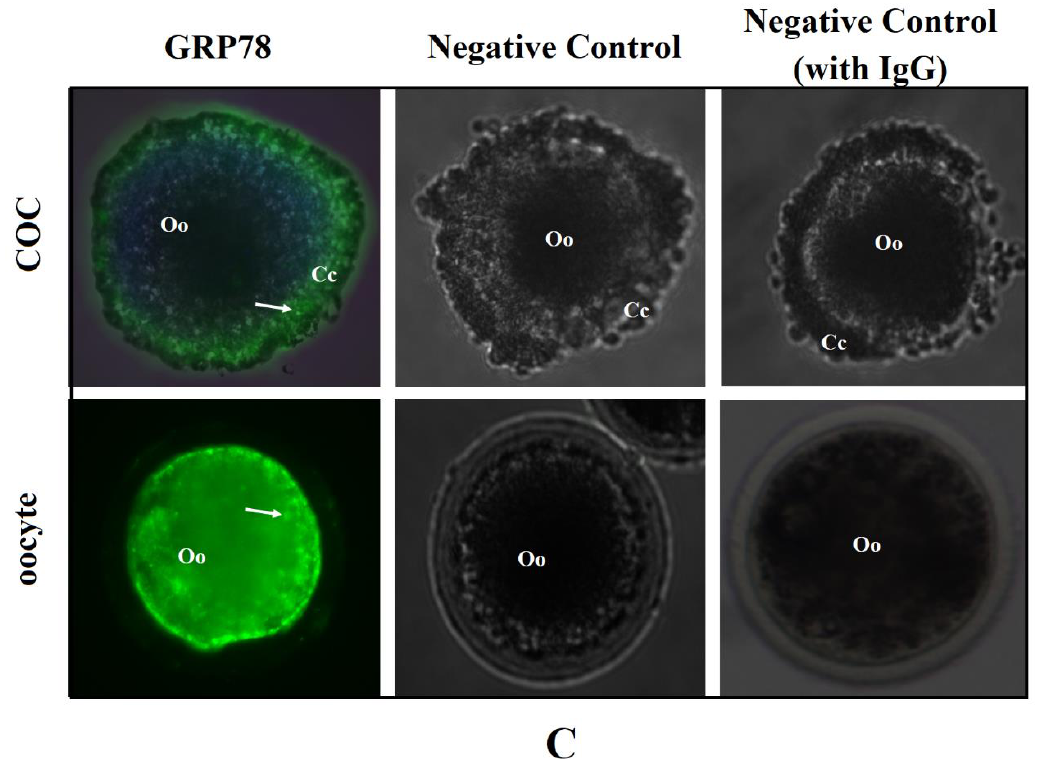
Figure 2. 78-kDa glucose-regulated protein (GRP78) mRNA and protein expression before and after oocyte in vitro maturation, as well as its immunolocalisation in cumulus–oocyte complexes (COCs). COCs (50/group/experiment) were selected after morphological examination of material collected from the ovaries taken from 100 pigs (15 follicles/ovary). COCs were collected before (0 h) and after (44 h) in vitro maturation and oocytes were denuded by gently pipetting in hyaluronidase, then real-time PCR and Western blot analysis were performed to determine mRNA ( A ) and protein ( B ) level of GRP78 in oocytes and cumulus cells. Immunolocalisation of GRP78 was studied by immunofluorescence in COCs ( C ). Gene expression level was normalised to the geometric mean of actin and glyceraldehyde 3-phosphate dehydrogenase ( GAPDH ), and protein to actin. GRP78 immunostaining shown by arrows. Experiments were performed independently and repeated three times ( n = 3). The data are plotted as the mean ± SEM of three independent experiments. Significance between groups before and after maturation is indicated by ** p < 0.01 and *** p < 0.001; Cumulus cells (Cc), oocyte (Oo), Immunoglobulin G (IgG).